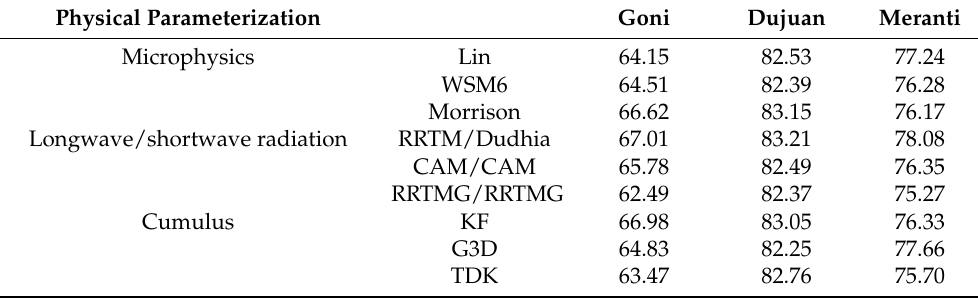
Table 16. Mean skill score for the single physical parameterization in the significant wave height simulation.